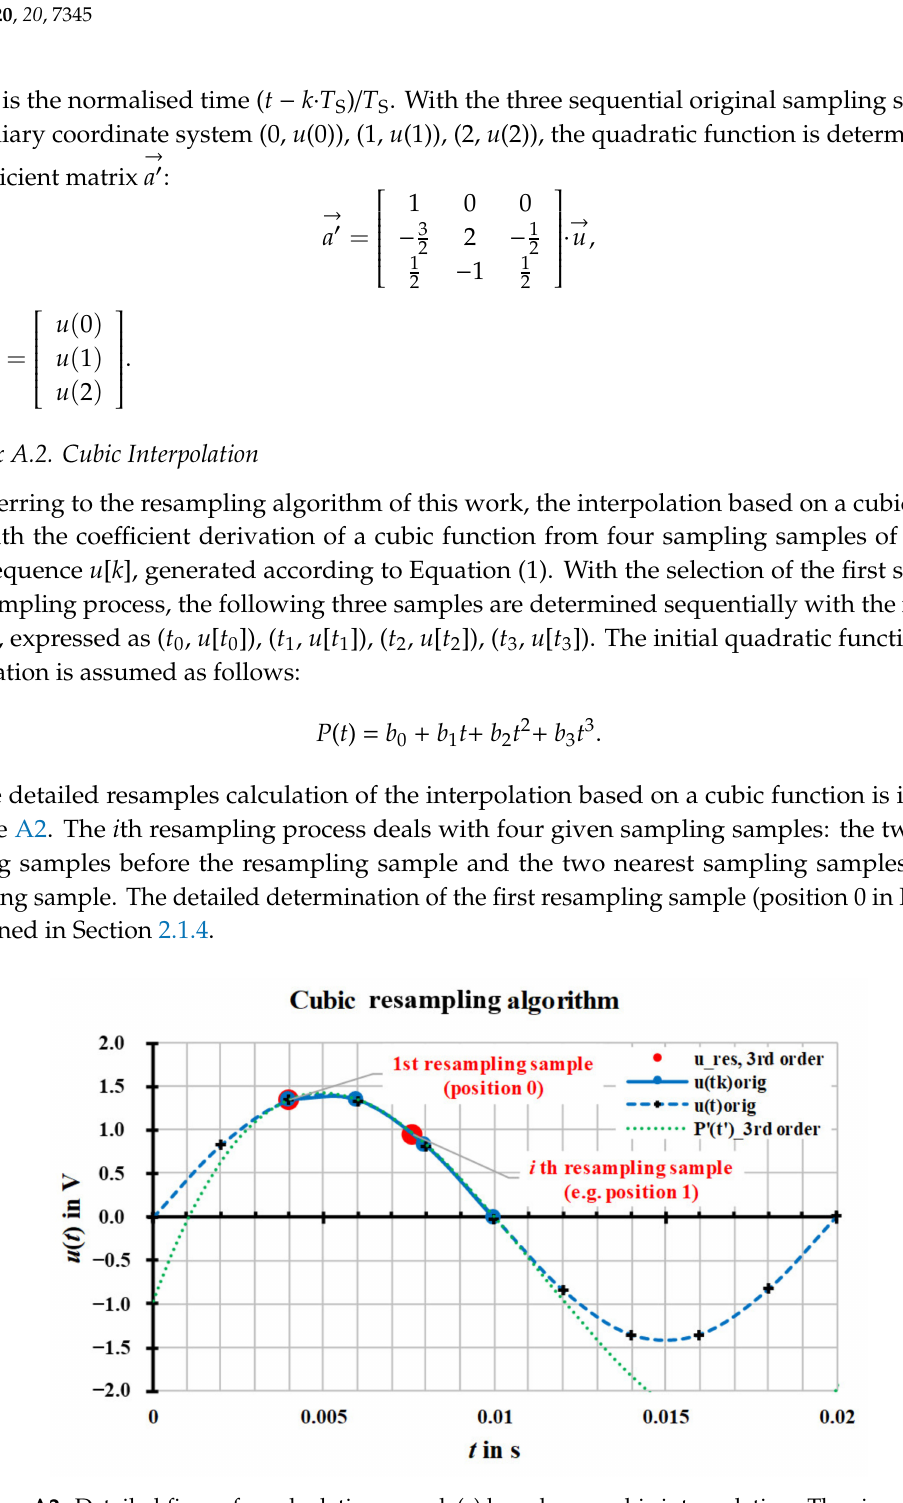
Figure A2. Detailed figure for calculating sample(s) based on a cubic interpolation. The signals are simulated with parameters of f S = 500 Hz, T W = 1 s, U 1 = 1 V, f 1 = 50.1 Hz, ϕ 1 = 0 ◦ , and T Del = 0.003 s without the noise and the harmonic series. The blue dashed curve with the black crosses represents the waveform of the sampling sequence. The four blue dots represent the selected original samples for the resampling process. The green dotted curve represents the determined cubic function. The red dots represent the samples after the resampling